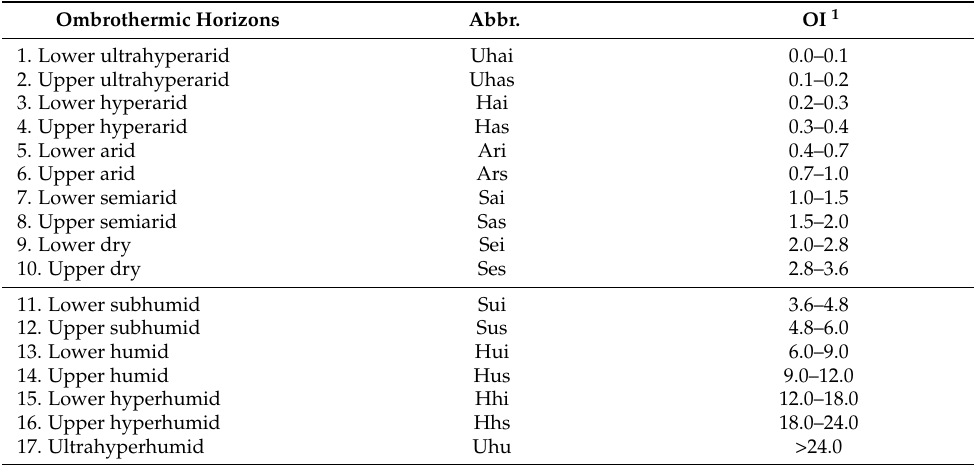
Table 2. Ombrothermic horizons, according to Rivas-Mart í nez et al. [23] Adapted with permission from Andrade and Contente [11]).